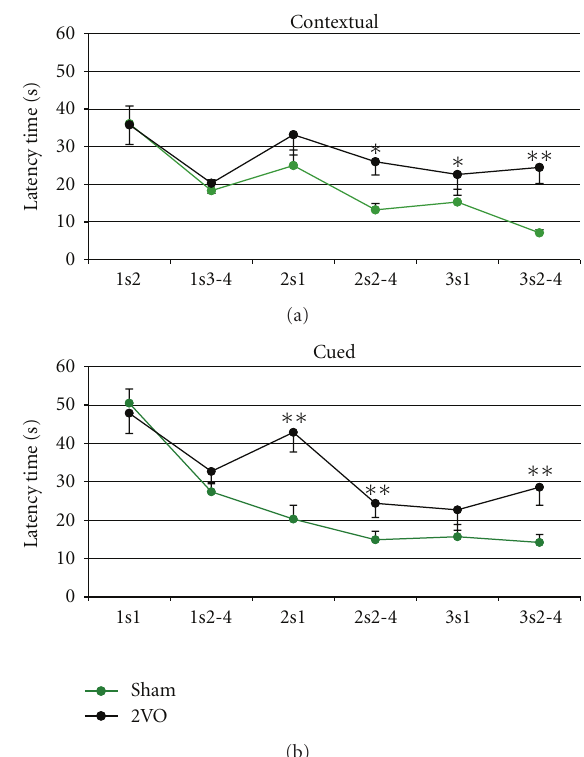
Figure 1: Behavioural performance of control and ischaemic rats in the Morris water maze. Graphs represent the swim latency time (sec, mean ± SEM) of the hidden platform achievement (behavioural criterion) by control (sham-operated, green curve) and ischaemic (2VO-operated, black curve) rats in spatial contextual (on the top) and spatial cured (on the bottom) behavioural